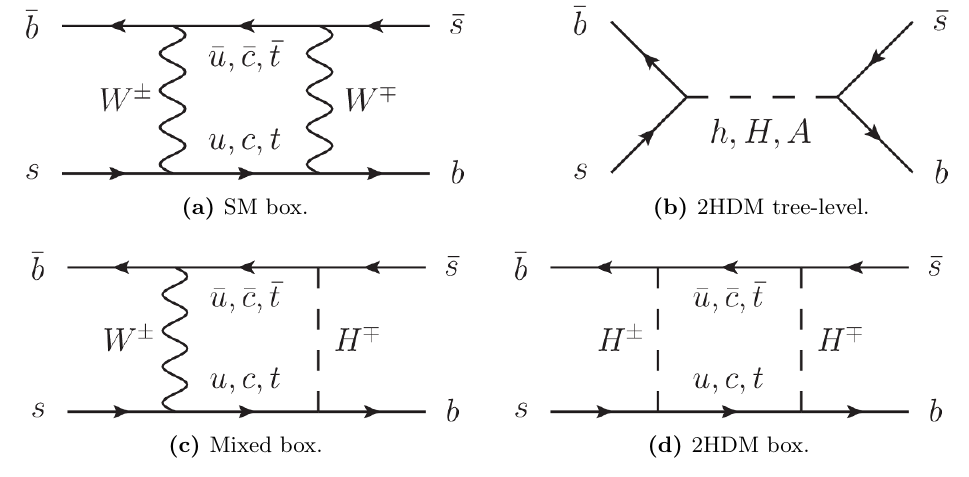
Figure 4 . Contributions to B 0